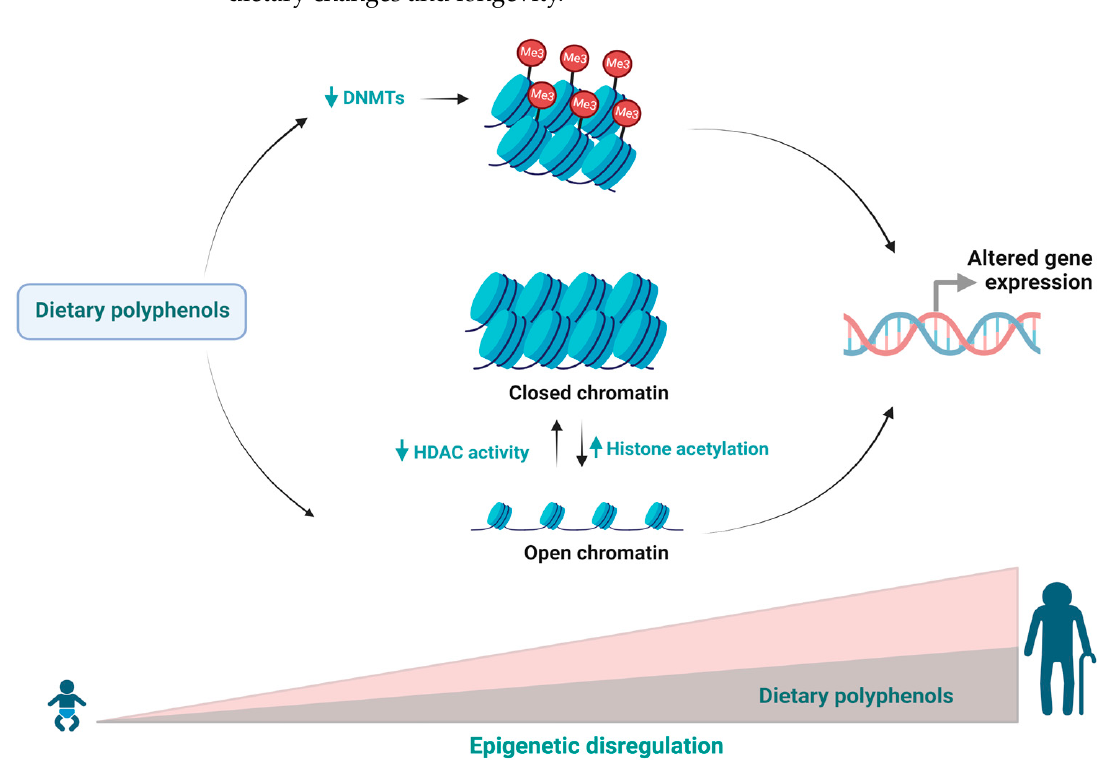
Figure 1. During ageing, epigenetic regulation changes in response to exogenous and endogenous factors affecting various biological processes. Dietary polyphenols can regulate epigenetic mechanisms and delaying the ageing process.